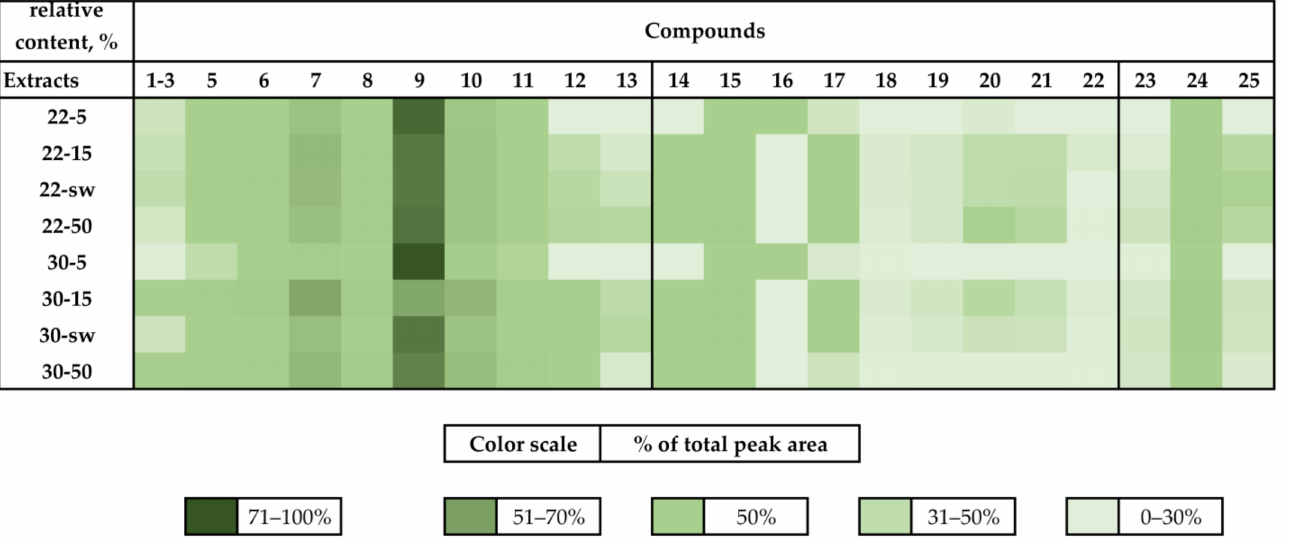
Figure 6. The heat map of a relative content of compounds 1 – 25 identified in fungal extracts. Each cell presents data about percentage of compound peak area to total area of peaks in